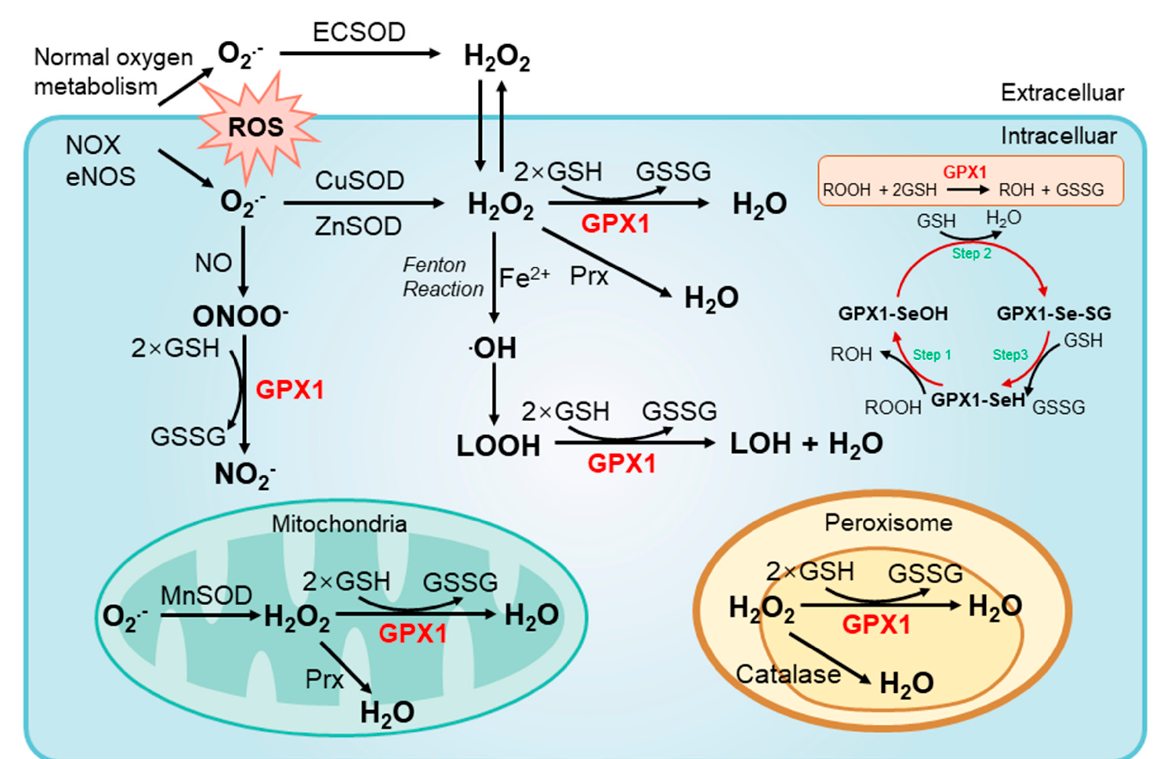
Figure 3. The enzymatic mechanisms of GPX1 to remove superoxides.